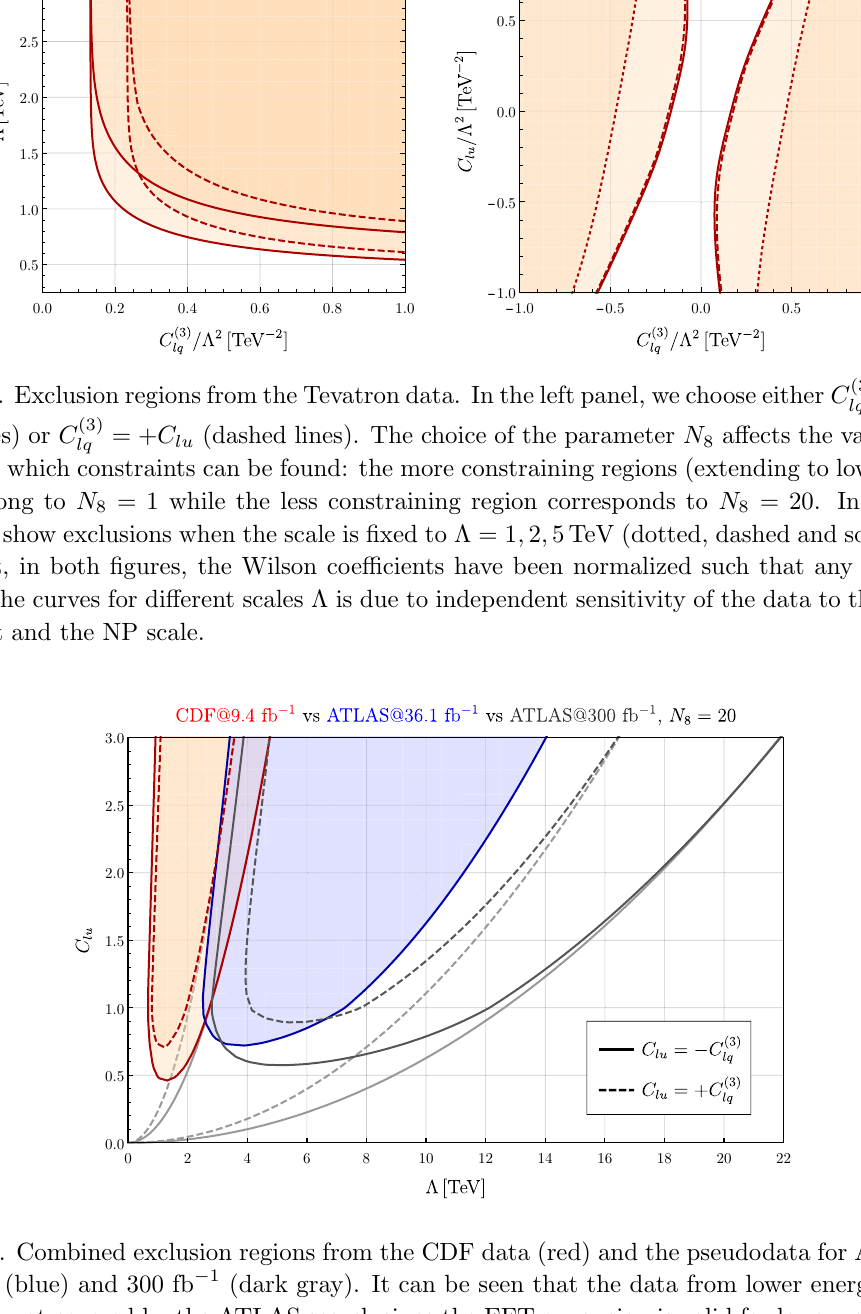
Figure 4 . Combined exclusion regions from the CDF data (red) and the pseudodata for ATLAS at 36 . 1 fb − 1 (blue) and 300 fb − 1 (dark gray). It can be seen that the data from lower energies closes the region not covered by the ATLAS search since the EFT expansion is valid for lower values of Λ. The light gray curves approximate the result of the search for CDF and future ATLAS data if the limiting behavior of dependence only on the ratio C/ Λ 2 were assumed throughout the parameter space; note that everywhere this fails the actual bounds are